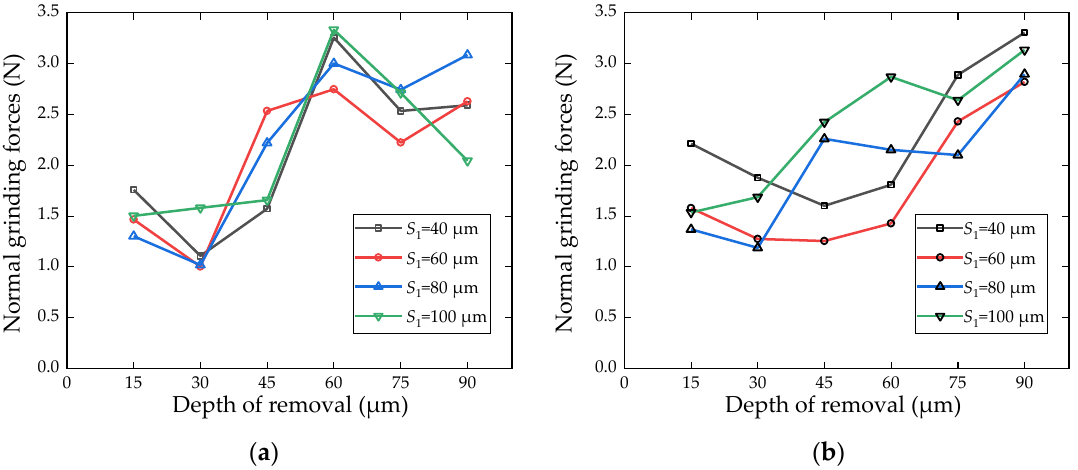
Figure 9. The relationship between the normal grinding force the total material removal thickness ( N = 40). ( a ) k = 49 kHz. ( b ) k = 20 kHz.